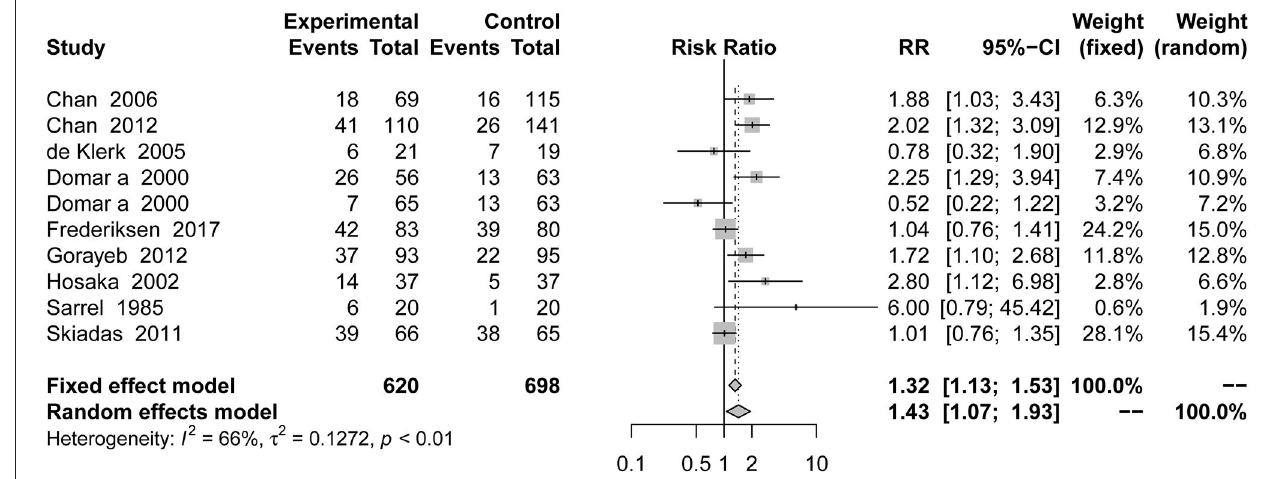
FIGURE 2 | Forest plot of pregnancy rate in pregnancy